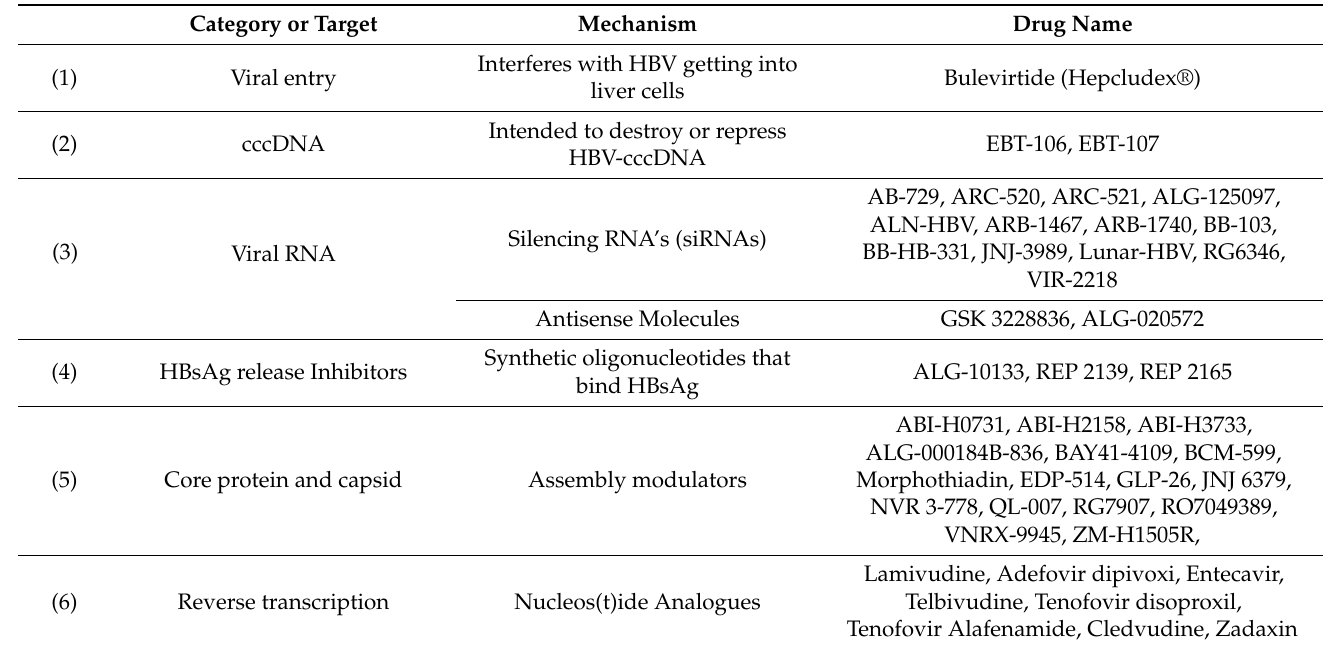
Table 1. HBV therapeutic agents targeting HBV directly (Hepatitis B Foundation: Drug Watch: https://www.hepb.org/ treatment-and-management/drug-watch/ (accessed on 7 August